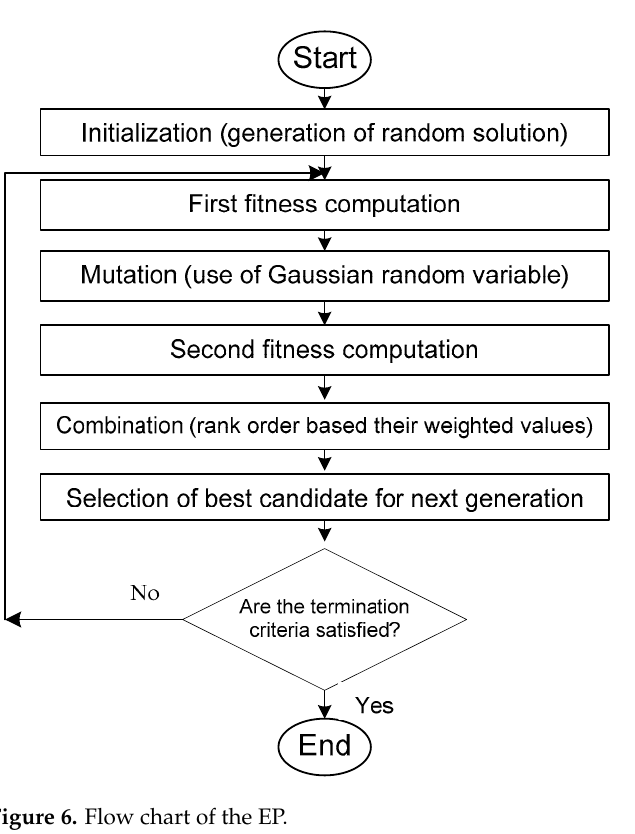
Figure 6. Flow chart of the EP .